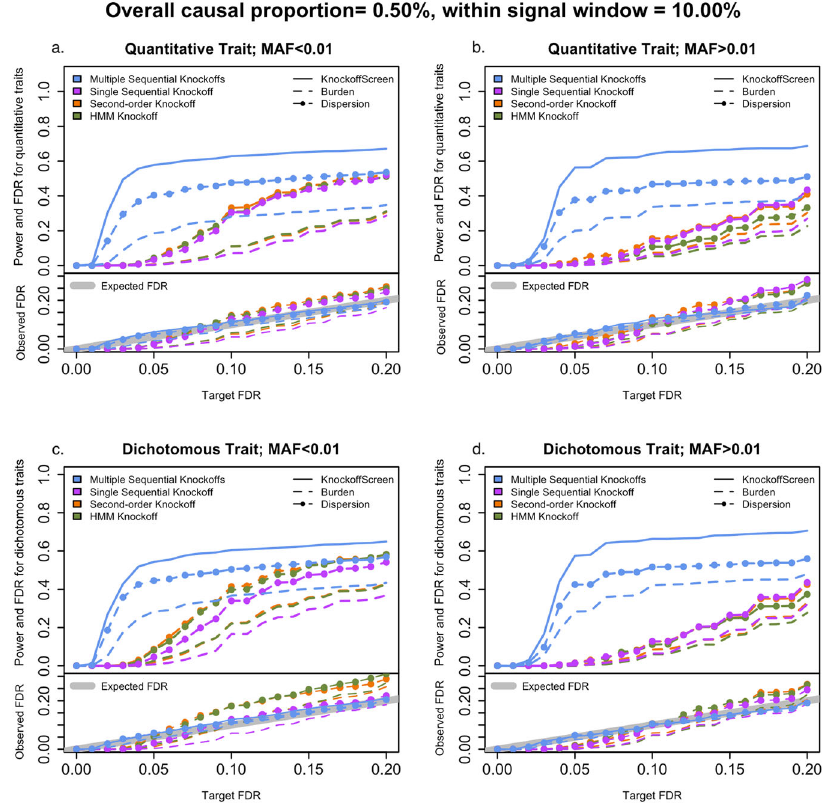
Fig. 2 Power and false discovery rate (FDR) simulation studies in a single region. The four panels show power and FDR base on 500 replicates for different types of traits (quantitative and dichotomous) and different types of variants (rare and common), with different target FDR varying from 0 to 0.2. The different colors indicate different knockoff generators. The different types of lines indicate different tests to de fi ne the importance score. Source data are provided as a Source Data fi